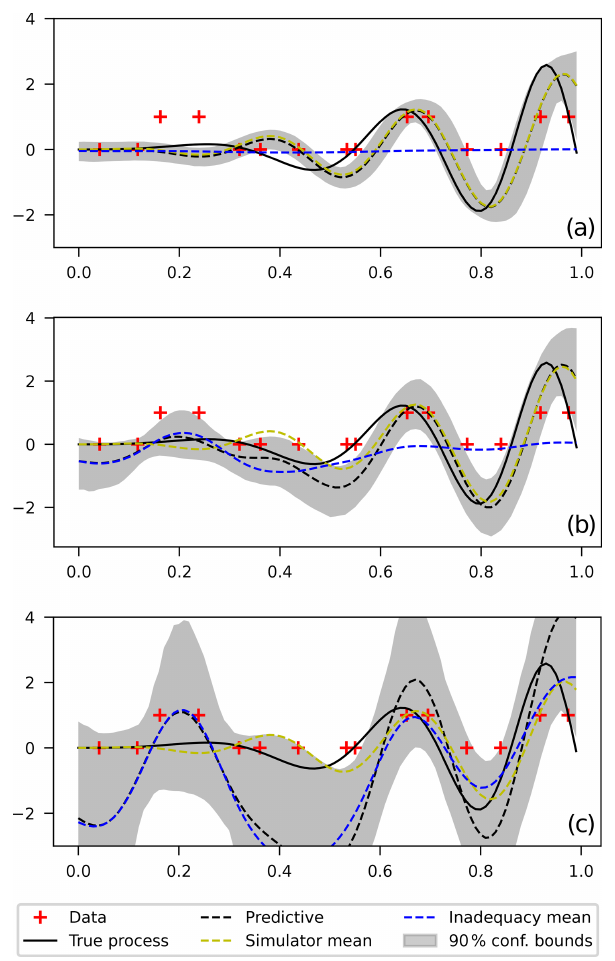
Figure 5. Comparison of calibration using both the simulator and the inadequacy function for different prior means for θ 1 : 0.02 (a) , 0.1 (b) , and 20 (c) .